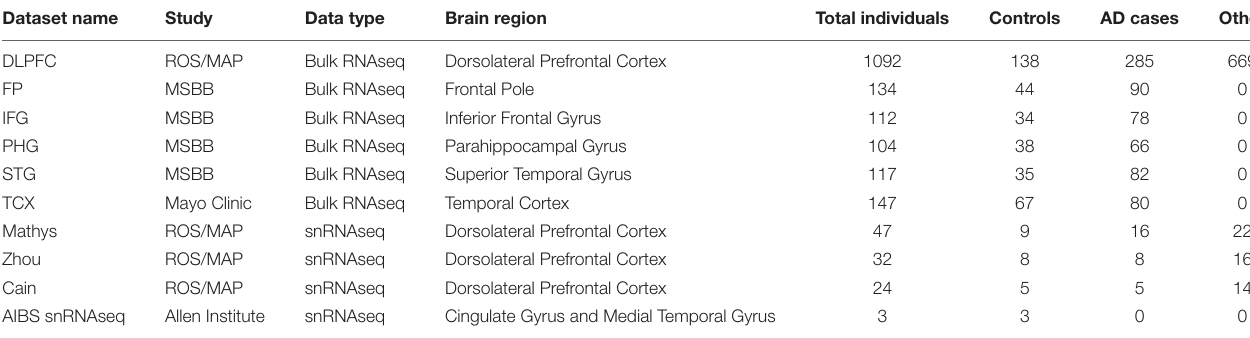
TABLE 1 | Summary of RNAseq datasets used in this